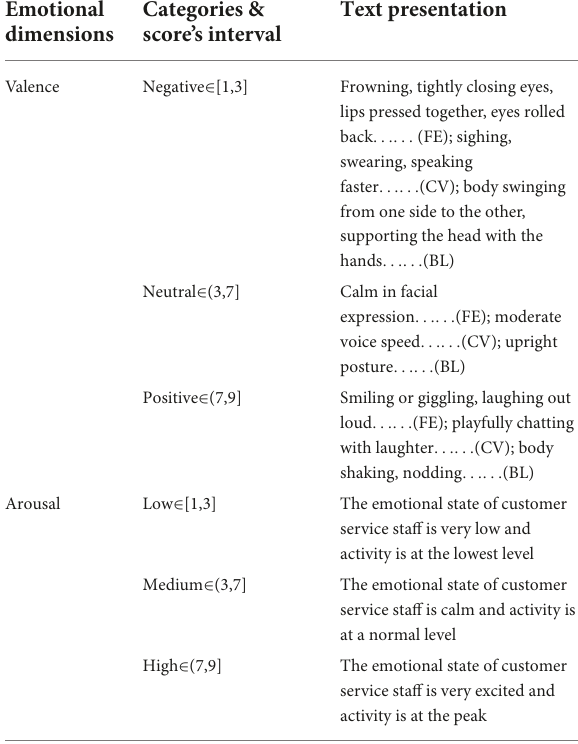
TABLE 2 The text classification of emotional valence &